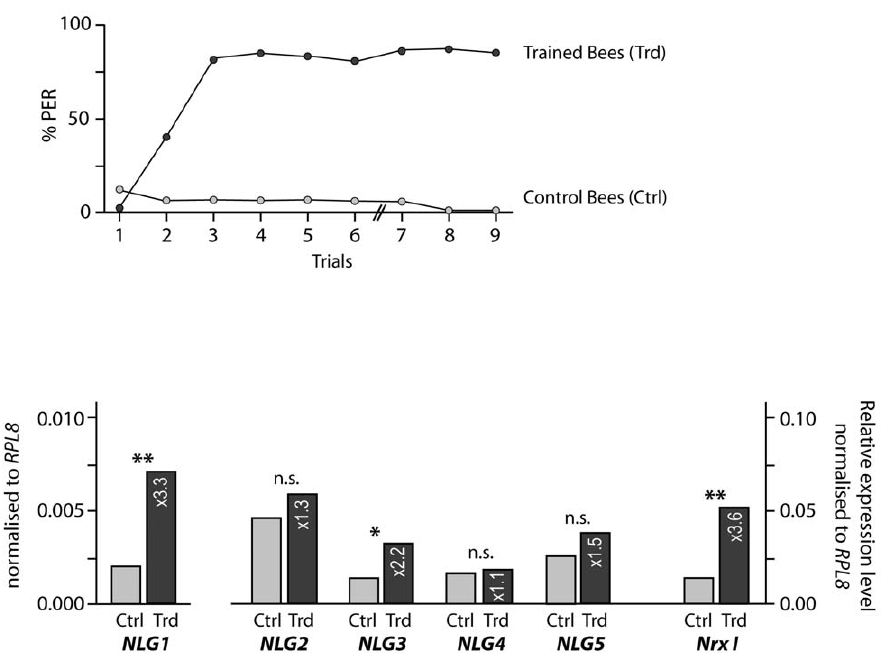
Figure 2. Effect of associative scent learning on expression of neuroligins and neurexinI in honeybee brain. Above: Acquisition of the Proboscis Extension Response (PER) by bees conditioned to associate lemon scent (CS) with a sugar reward (US) (Trained Bees), and bees that received the backward control (US presented before CS) (Control Bees). Nine trials were conducted over two days, using 23-day old bees. 20 bees per group were tested (for details see Materials and Methods). Below: Expression of neuroligins and neurexin I in honeybee brain tissue comparing trained bees (Trd) with control bees (Ctrl). NLG1: neuroligin 1, NLG2: neuroligin 2, NLG3: neuroligin 3, NLG4: neuroligin 4, NLG5: neuroligin 5, NrxI: neurexin I . Expression levels were assessed by quantitative real time PCR amplification; the detailed methodologies are as described in the legend to Figure 1. Expression levels are shown relative to RPL8 ( RPL8 expression was equivalent in all experimental cohorts of bees: standard deviation 6 0.03–0.30 across all samples). Neuroligin and neurexin I expression levels shown are means of three technical replicates each. Standard errors were negligible and less than 6 1.22 for all experimental results. ** p , 0.01, * p , 0.05, n.s. no significant difference ( t -test). Raw data from the qRT-PCR experiment are in Table